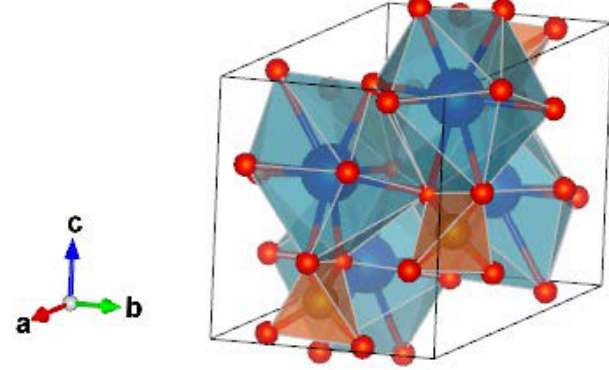
Figure 1. ( Color online ) Crystal structure of monazite-type GdPO 4 . Oxygen, phosphorus, and gadolinium atoms are shown in red, orange, and blue, respectively. The PO 4 tetrahedral units and the GdO 9 polyhedral units are also shown.